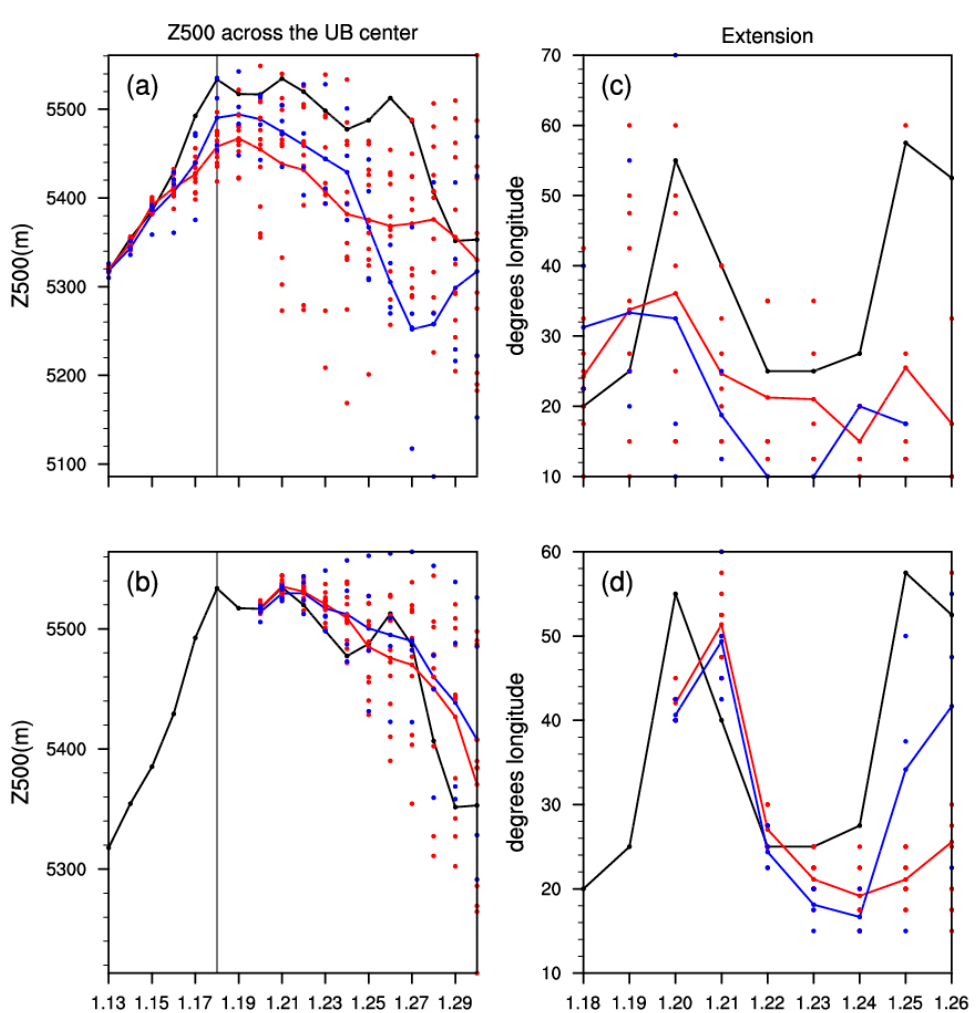
Figure 4. ( a , b ) UB intensity (units, gpm) from January 13 to January 29, 2012. ( c , d ) UB extension from January 18 to January 26, 2012. The black line is observations, the red (blue) dots are the prediction of 11 (4) members for the ECMWF (ECCC) model, and the red (blue) line is the ensemble-mean of the ECMWF (ECCC) model. In ( a ) and ( c ) (( b ) and ( d )) , the predictions were initialized on January 12 (19).